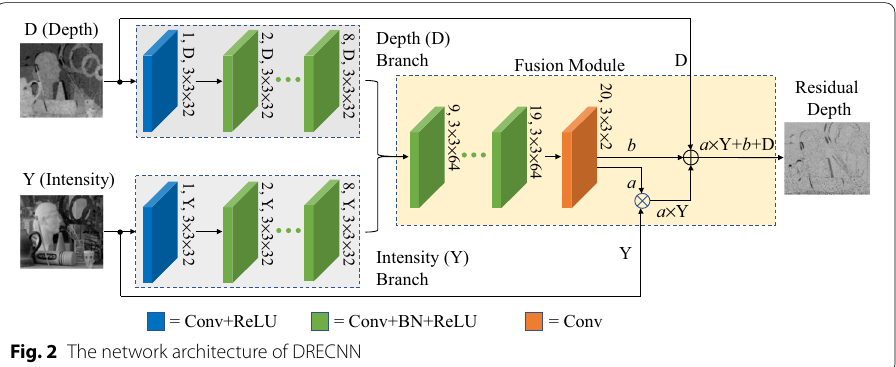
Fig. 2 The network architecture of